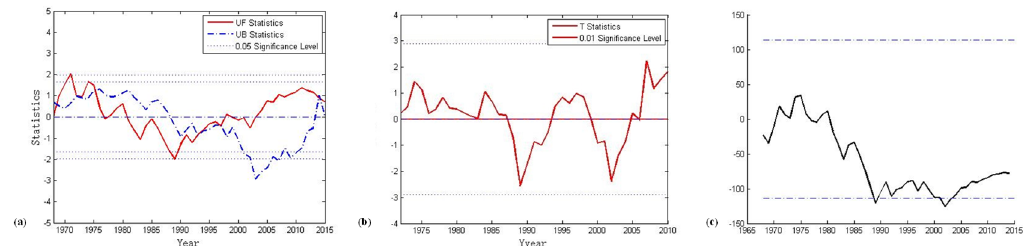
Figure 4. Results of rainfall analysis through three methods: ( a ) Mann–Kendal test, ( b ) sliding t -test, and ( c ) Pettitt test.